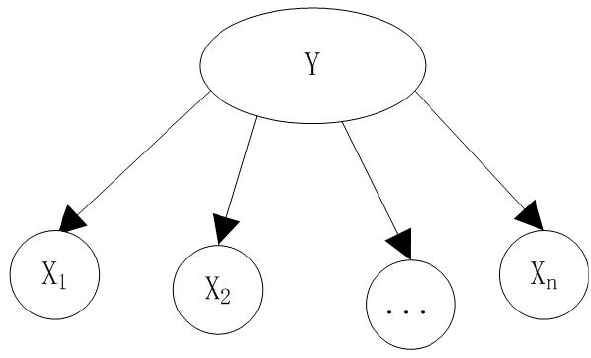
Figure 2. The structure of the Naïve Bayes.